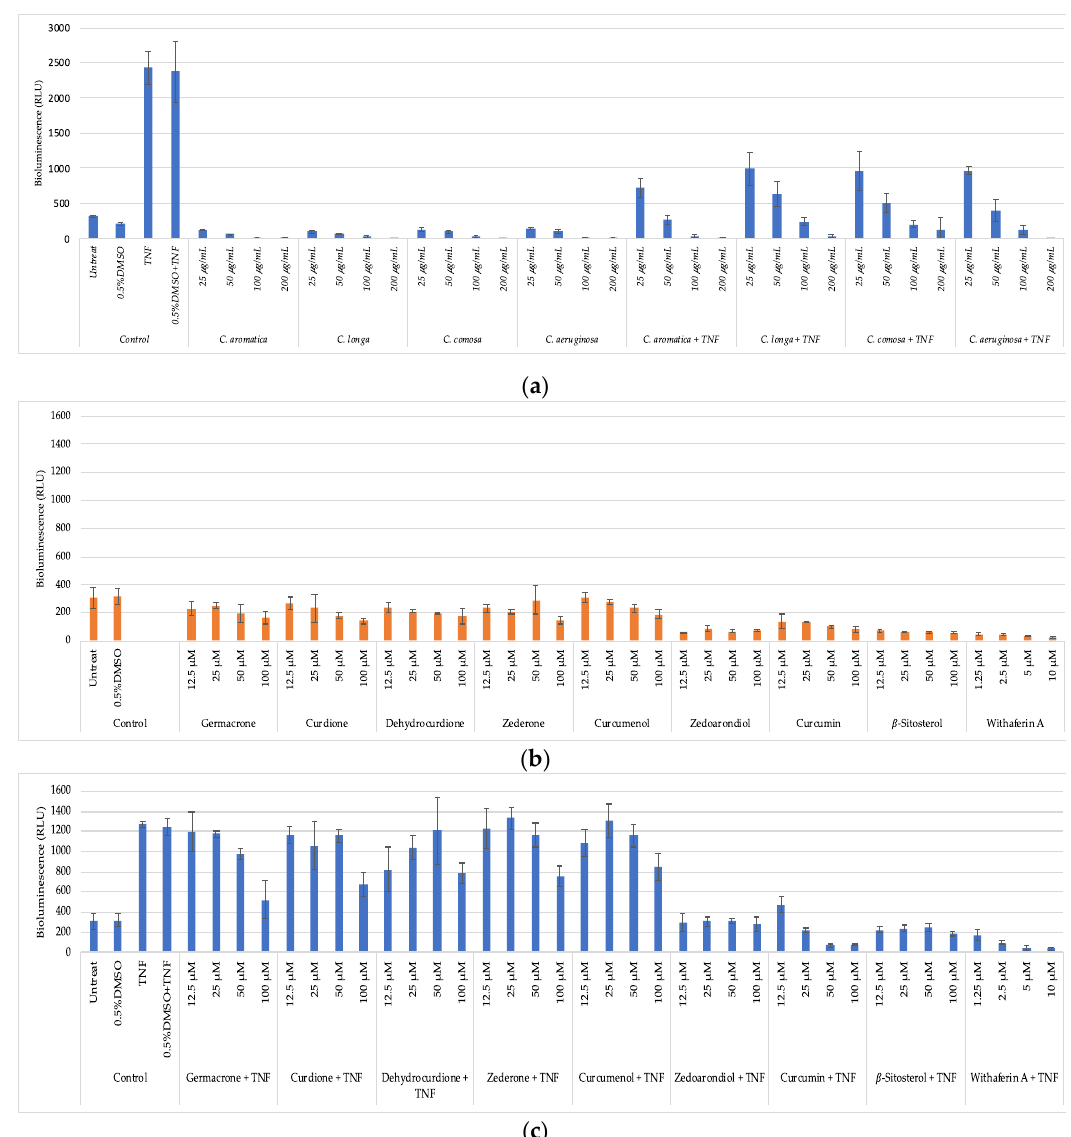
Figure 5. Anti-inflammatory effects of four Curcuma species and pure compounds isolated from C. aromatica measured in HaCaT NF- κ B reporter gene cells. ( a ) Dose dependent effects of crude extracts of Curcuma species on basal and inflammation induced NF- κ B reporter gene (luciferase relative light units) expression. ( b ) Dose dependent effect of pure compounds isolated from C. aromatica and the reference NF- κ B inhibitor compound (withaferin A) on basal and inflammation induced NF- κ B reporter gene (luciferase relative light units) expression. ( c ) Dose dependent effect of pure compounds isolated from C. aromatica and the reference NF- κ B inhibitor compound (withaferin A) on basal and inflammation induced NF- κB reporter gene (luciferase relative light units) expression.